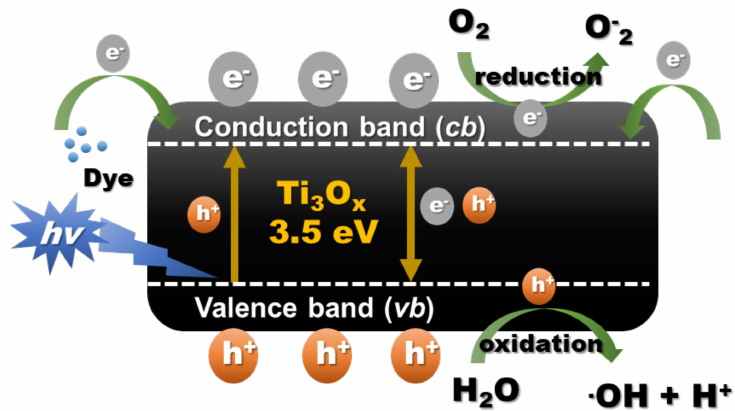
Figure 9. Schematic diagram energy bandgap of Ti 3 O x thin films showing the charge transportation process leading to light irradiation-driven photocatalytic degradation of methylene blue. Film thickness and energy bandgap are two key factors determining the photocatalytic performance of Ti 3 O x thin films. The energy bandgap of Ti 3 O x thin films is ~3.5 eV, which is higher than the rutile (3.0 eV) or anatase (3.2 eV) phases. According to Qutub et al.